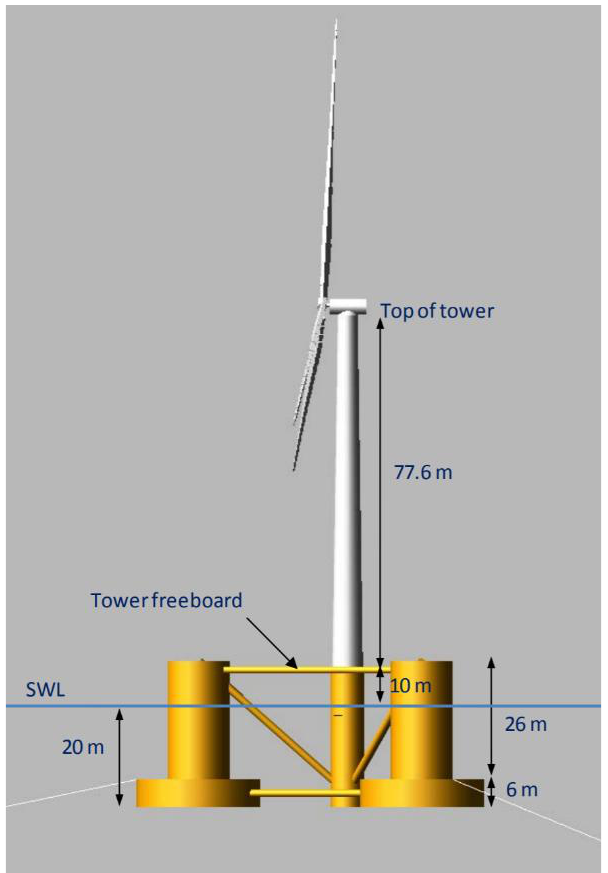
Figure 11. Design of floating wind system with OC4 semisubmersible platform [50].